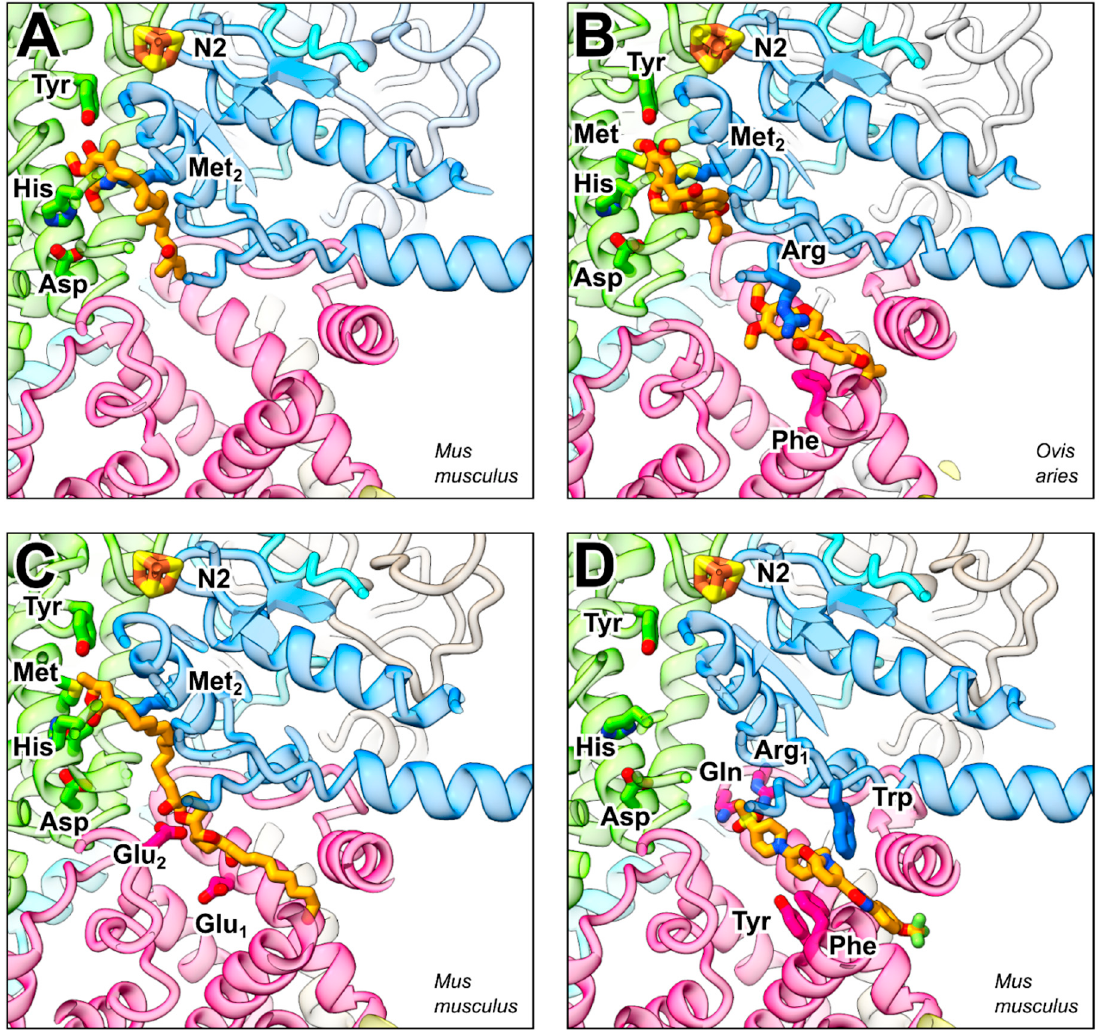
Figure 3. Binding of natural inhibitors and IACS-2858 to respiratory complex I. Q reduction site near FeS cluster N2 and access pathway as shown in Figure 2. ( A ) Piericidin A bound to complex I from M. musculus (PDB ID 6ZTQ), ( B ) two rotenone molecules bound to complex I from O. aries (PDB ID 6ZKN), ( C ) annonaceous acetogenin (compound 1 as described in Grba et al., 2022) bound to complex I from M. musculus (PDB ID 7PSA), and ( D ) the synthetic anti-cancer agent IACS-2858 bound to complex I from M. musculus (PDB ID 7B93); for residue numbering see Table 1.